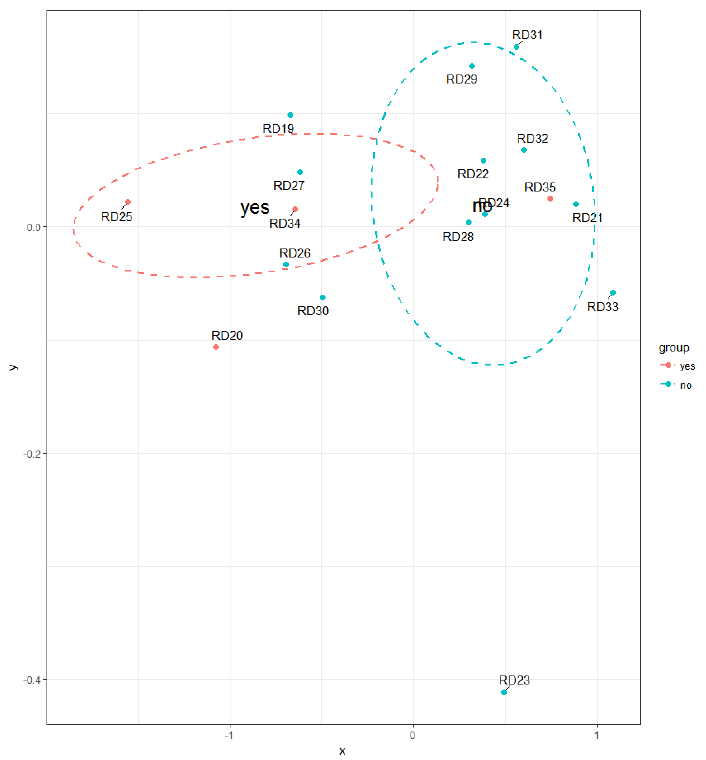
Figure 16. NMDS visualizing the level of similarity for the factor—windows opening during cleaning activities.